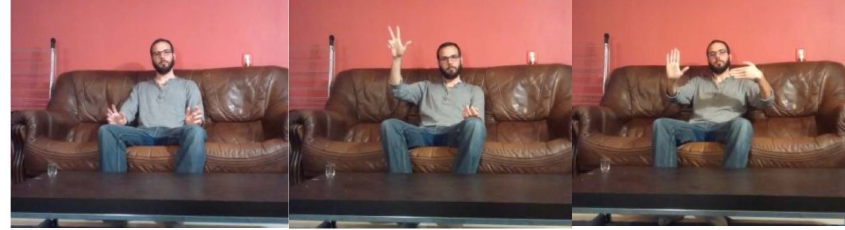
Figure 14. A user at rest, issuing commands with the right hand and issuing commands with both